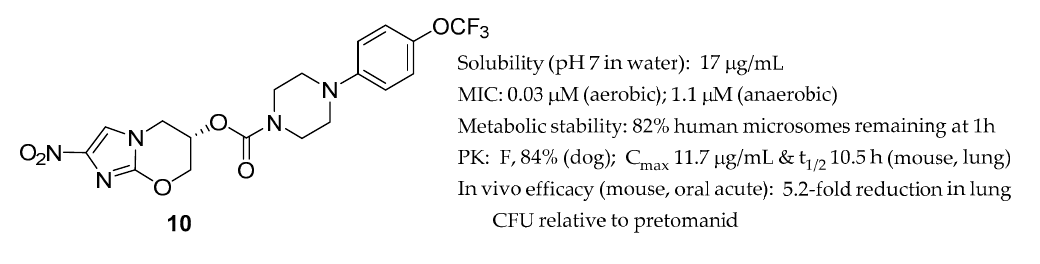
Figure 5. Profile of potential development compound 10 .